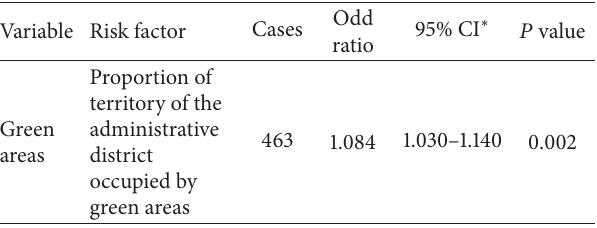
Table 2: Final multivariate analysis of risk factors associated with intestinal parasites in dog faecal samples collected in public areas of Milan (north-western